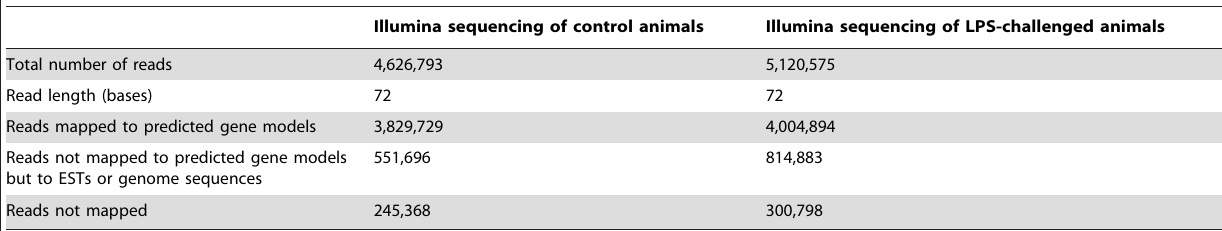
Table 1. Summary statistics for Tribolium castaneum transcriptome sequencing